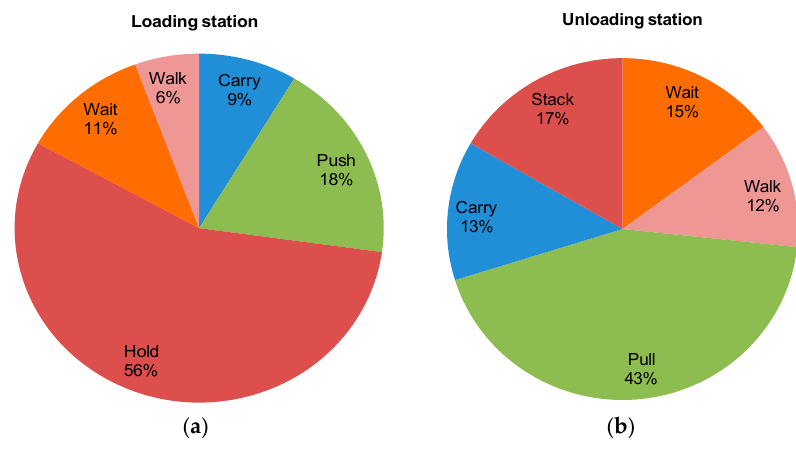
Figure 3. Percentage breakdown of observations among different tasks, by work station, ( a ) loading station, ( b ) unloading station.